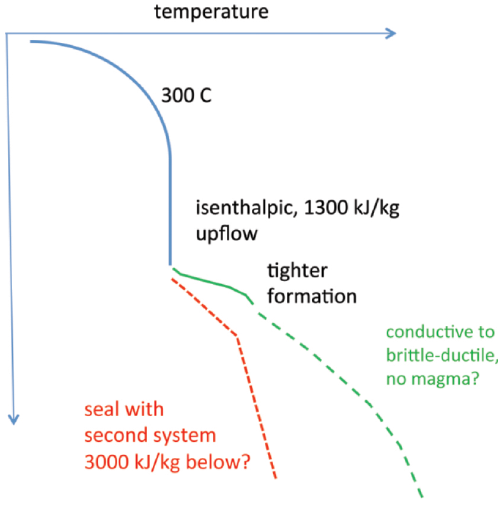
Figure 5. Thermal structure of the up-flow zone for di ff erent con- ceptual models of geothermal systems. Notice di ff erence in thermal structure at